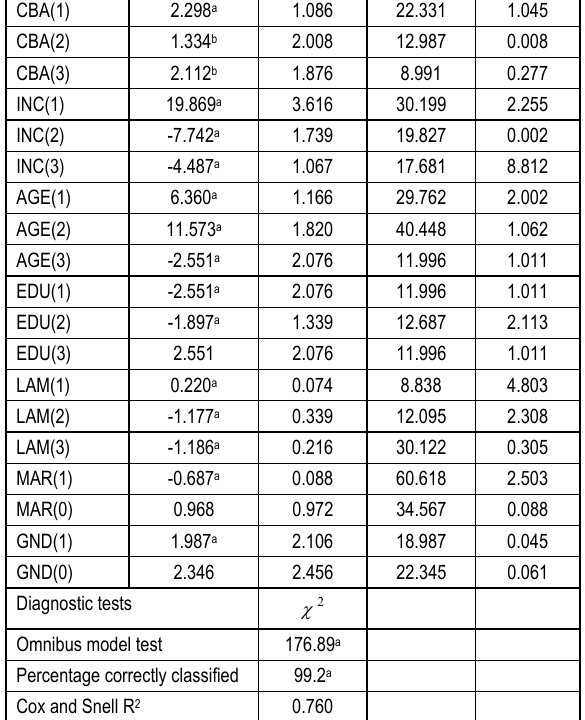
Table 4 (cont.). Correlation results of credit risk